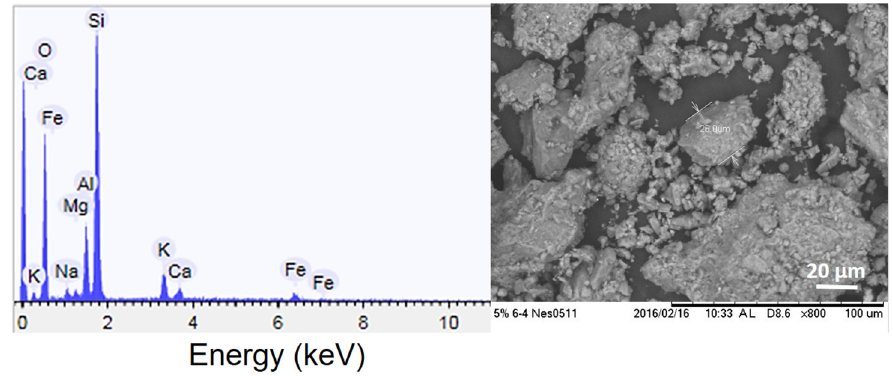
Figure 2. SEM Image and EDS Analysis of Raw Zeolite Particle.